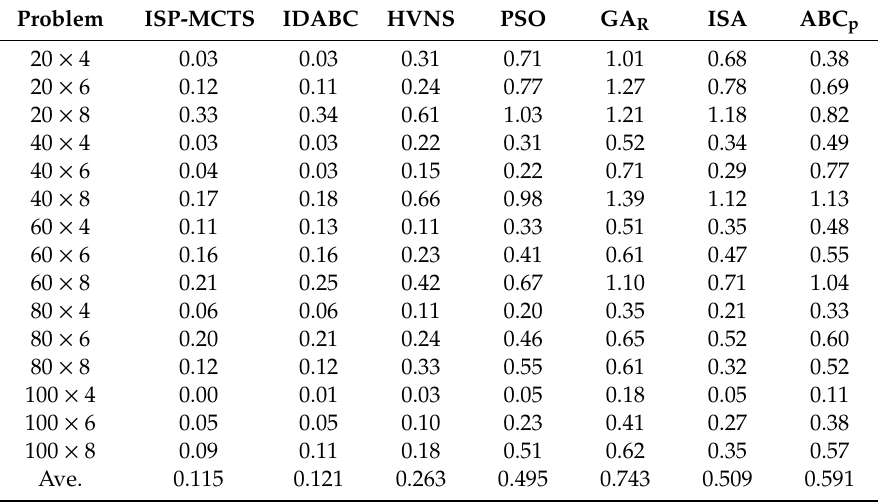
Table 9. Computational results of the algorithms ( ρ = 10).